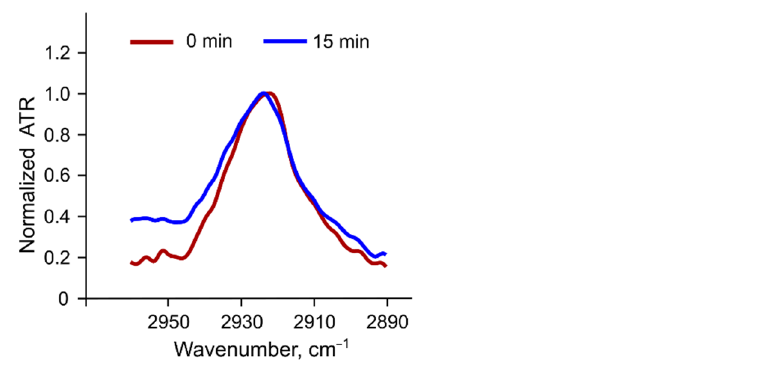
Table 3. Correlation between secondary structure element in BSA and Amide I second derivative position 1